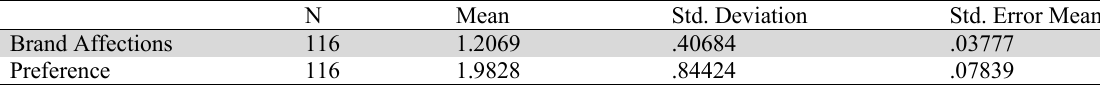
One- Sample t-test Statistics